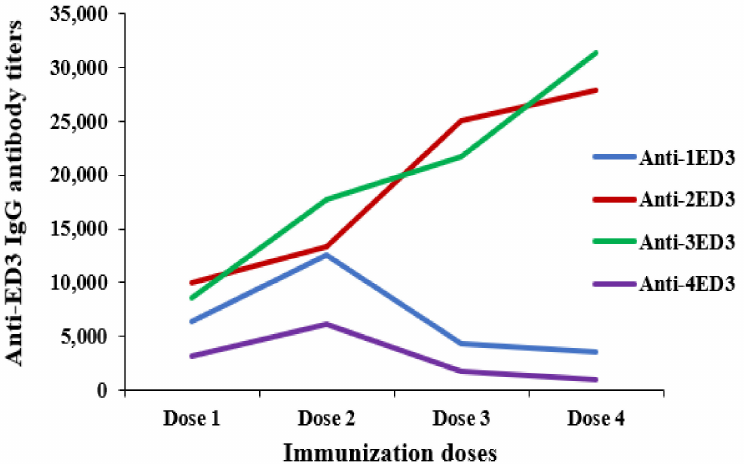
Figure 2. Long-term anti-ED3 IgG responses in BALB/c mouse model. Dose-specific anti-1ED3, anti-2ED3, anti-3ED3, and anti-4ED3 IgG responses (antibody titers) are shown. The sampling was done 28 days after each immunization with a 35-day interval between immunizations. The anti-ED3 IgG responses increased following the first two doses but decreased following doses 3 and 4 with 1ED3 and 4ED3. However, the dose-specific anti-2ED3 and anti-3ED3 IgG titers levels increased with repeated immunization